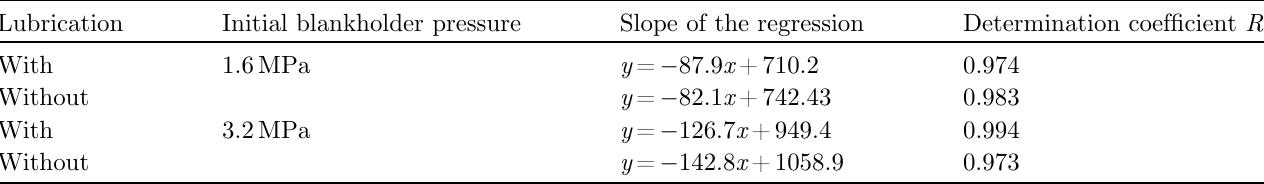
Table 7. Regression analysis of variation of the drawing radius in the case of using bronze tool.